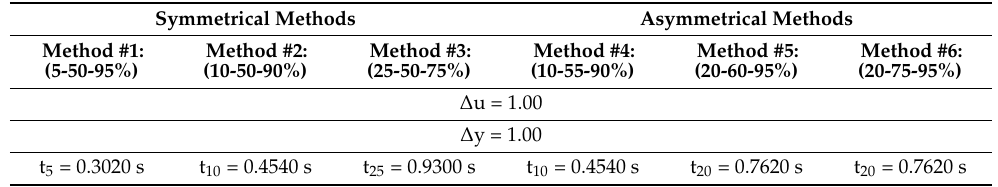
Table 10. Process information collected from the reaction curve for fractional-order model identifica- tion of process P 1